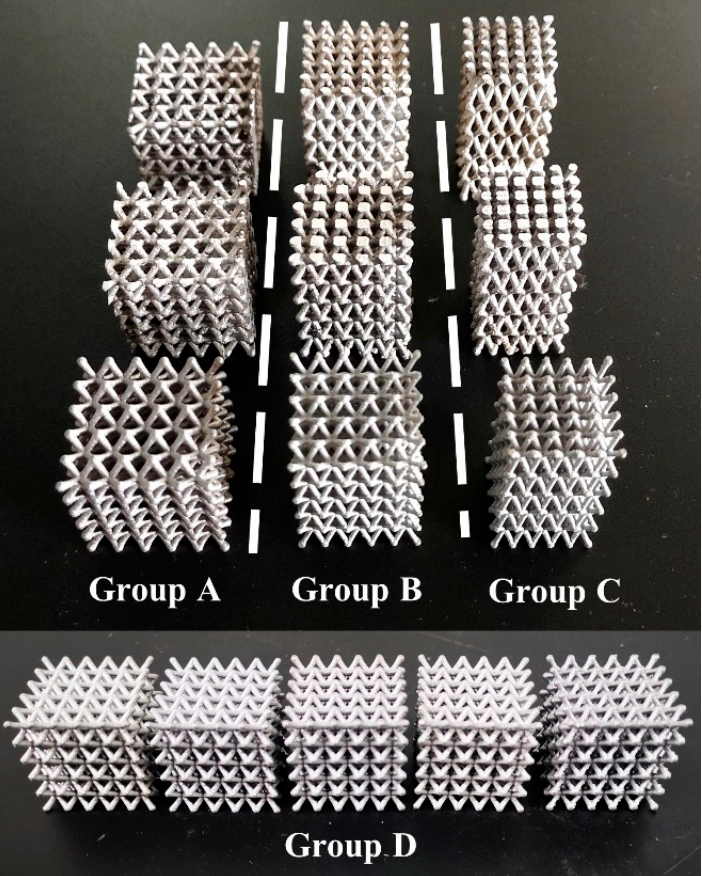
Figure 4. Four group samples, A, B, C and D, of node-enhanced pyramidal lattice structures.